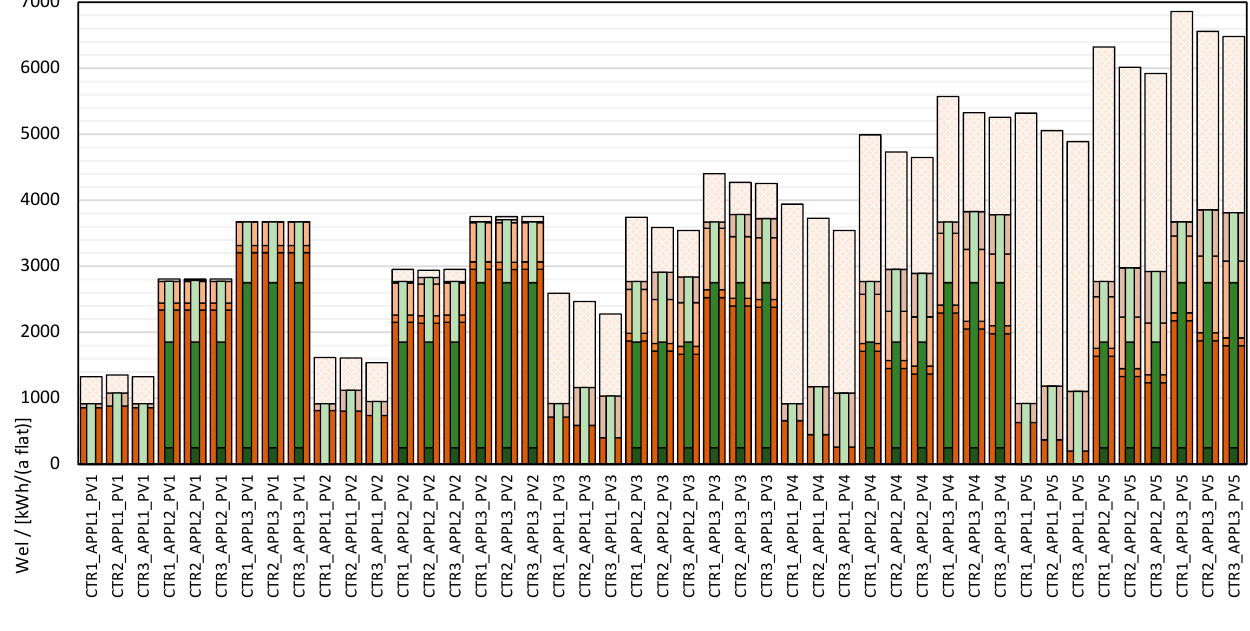
Figure 13. Electricity balance for all the cases considering no batteries and averaged results over the three DHW profiles.